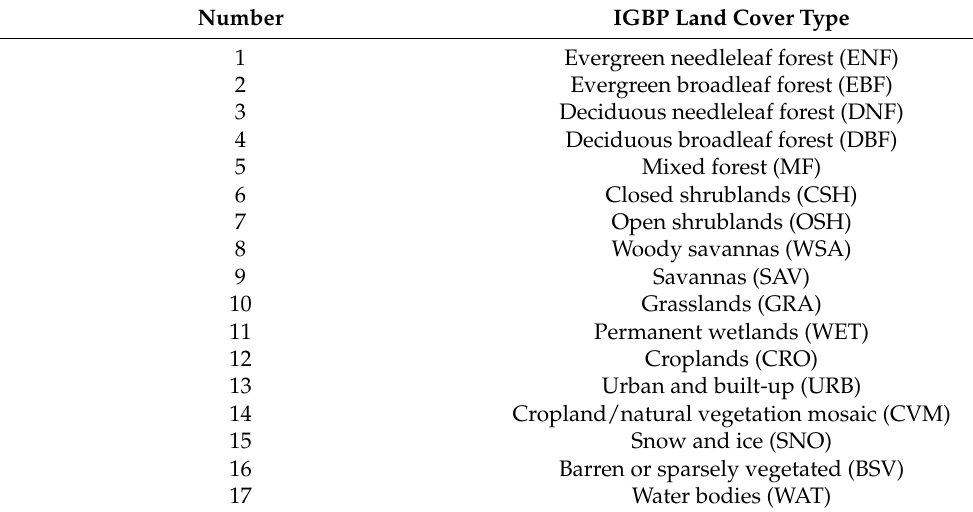
Table 2. IGBP Land Cover Type.